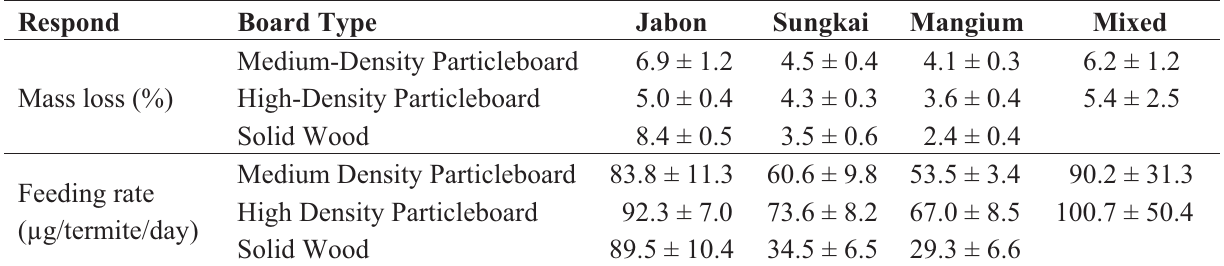
Table 2. Mass loss and feeding rate of each wood species particleboard and its type. Respond